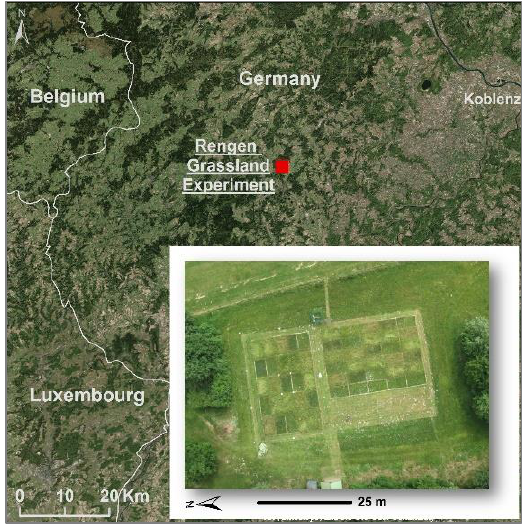
Figure 1. Overview of the Rengen Grassland Experiment (Inset photo: G. Bareth, 2014).